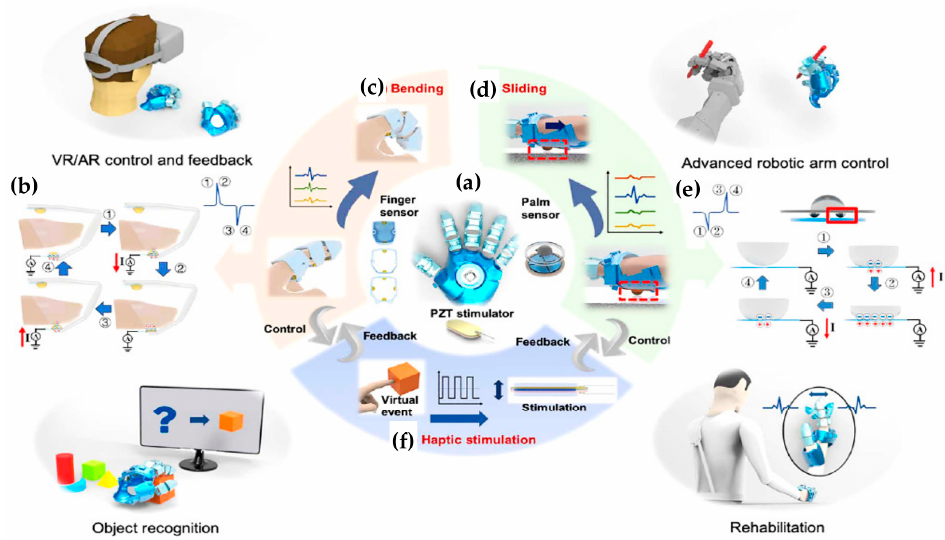
Figure 9. Glove-based HMI for general purposes; it includes ( a ) triboelectric finger sensors for sensing bending movements ( b ) with a related operating principle ( c ), a triboelectric palm sensor ( c ) for detecting the sliding movements ( d ) with a related operating principle ( e ), and piezoelectric mechanical stimulator for generating haptic feedback ( f ) [34].